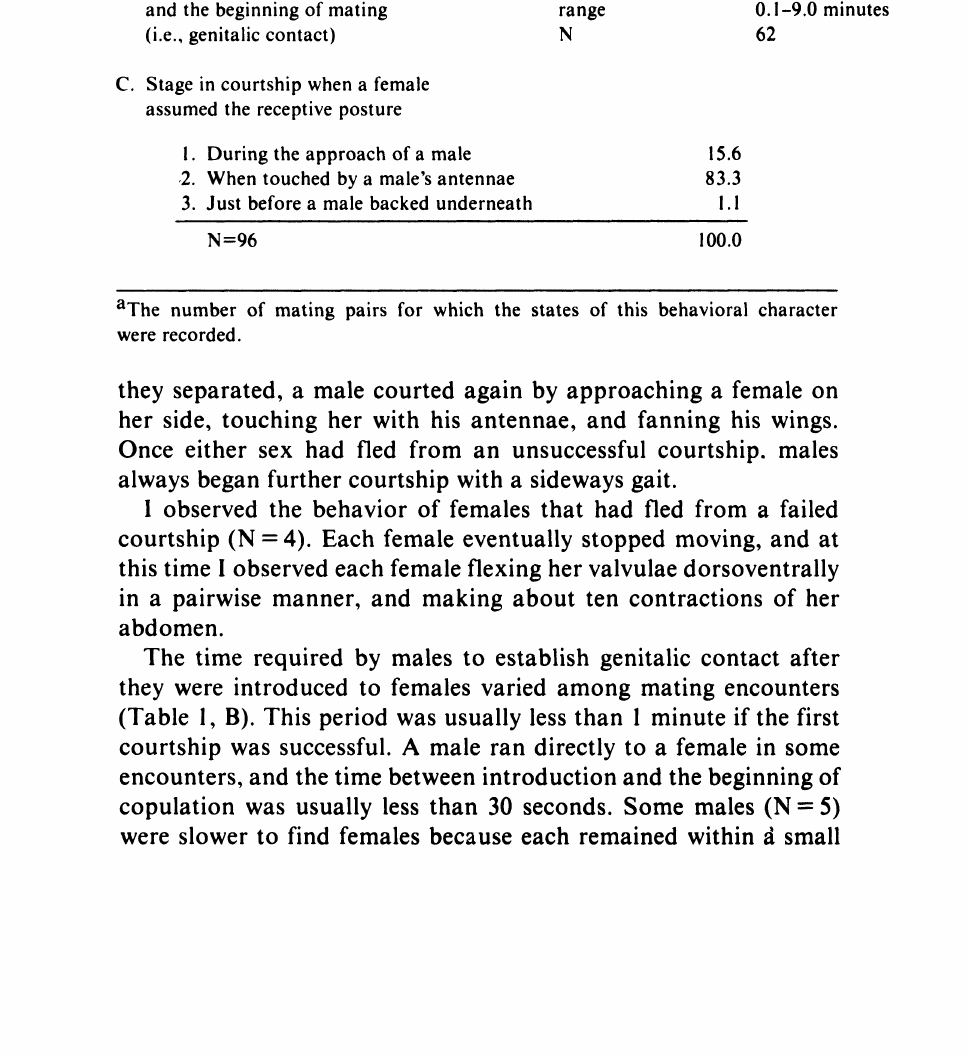
A. Number of courting